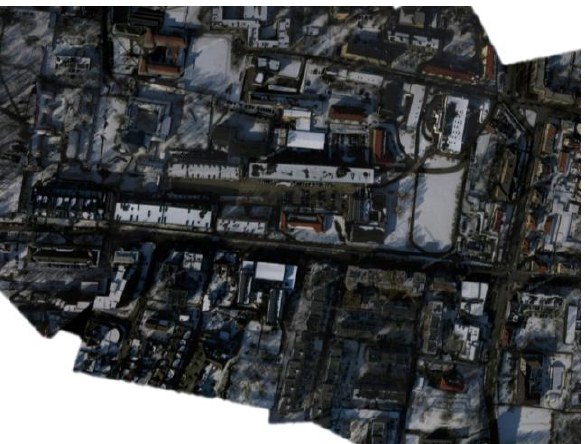
Figure 6. Ortophotomosaic of the city